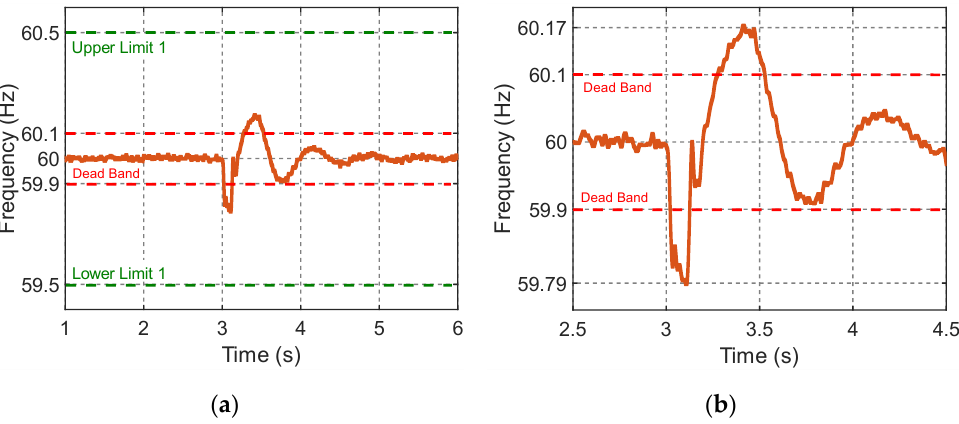
Figure 12. Scenario 1, system ’ s frequency: ( a ) frequency; ( b ) frequency (zoom).